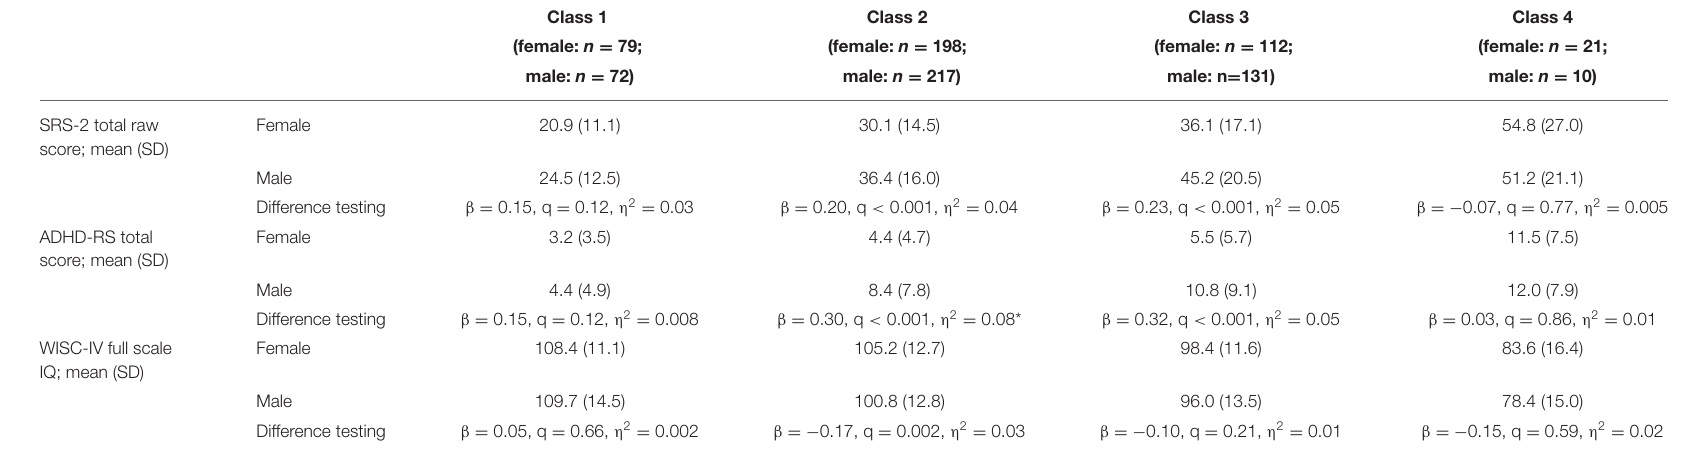
TABLE 4 | Sex differences in the number of children who exceeded the cut-off values of neurodevelopmental traits at age 9 in each latent class. Class 1 Class 2 Class 3 Class 4 (female: n = 79; (female: n = 198; (female: n = 112; (female: n = 21; male: n = 72) male: n = 217) male: n = 131) male: n = 10) Autistic traits (SRS-2 total T-score ≥ 60 for Female 1 (1.3) male and ≥ 62 for female); n (%)